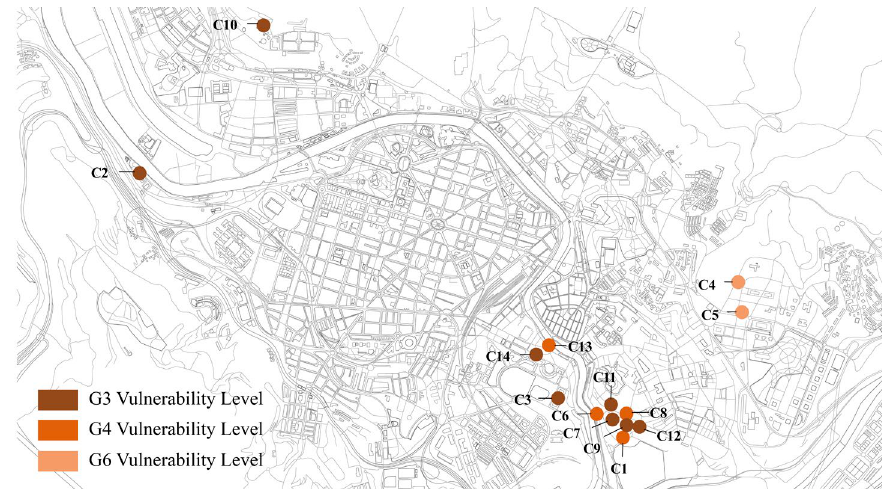
Fig. 5. Fuel poverty assessment graph for CAPV households for 2016 [10].